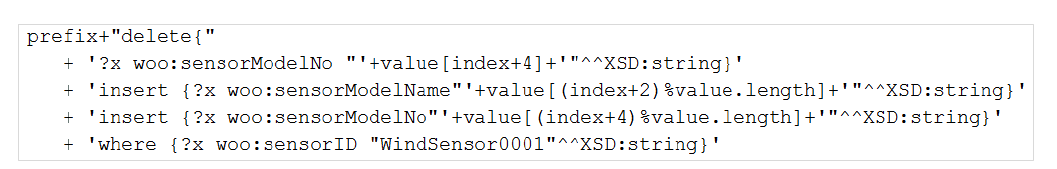
Figure 25. Update of a sensor VO using SPARQL query.